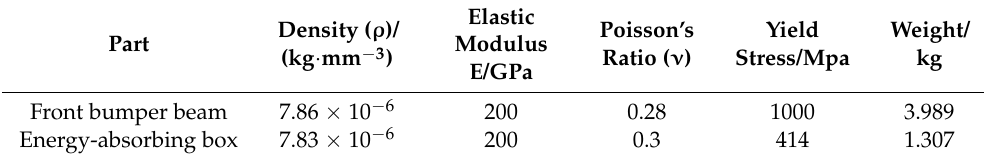
Table 3. The parameters of front bumper beam made of high-strength steel (DP1400).